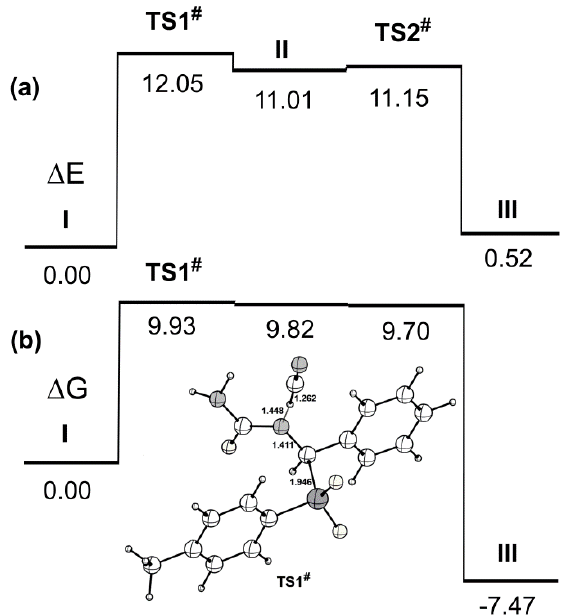
Figure 2. Calculated electronic ( a ) and Gibbs free energy ( b ) profiles for the transformation of 4a (conformer A ) into acylimine 7a under the action of cyanide-anion in DMF solution (1 atm, 298 K). The relative energies are given in kcal/mol. A view of the transition state TS1 # with selected bond lengths is presented.